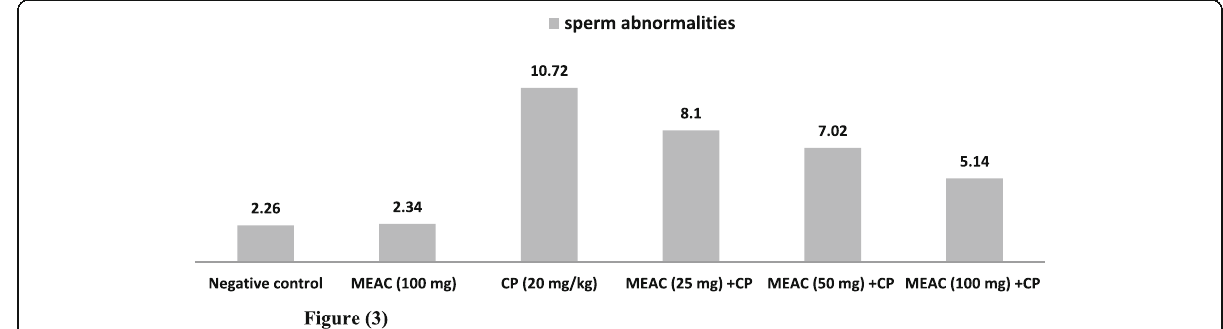
Fig. 3 Frequency of sperm abnormalities induced after treatment with different doses of MEAC and CP showed a dose-related